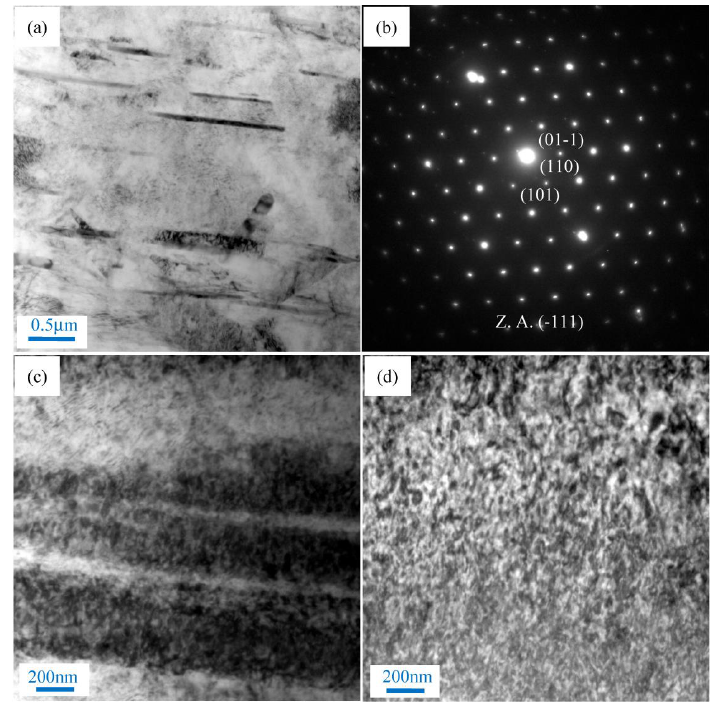
Figure 4. Transmission electron microscopy (TEM) micrographs of nano-SiCp/AZ91 composite after single-pass forging at a temperature of 350 °C: ( a ) precipitated phase; ( b ) electron diffraction patterns of the precipitated phase; ( c ) deformation band; ( d ) dislocation within the deformation band.